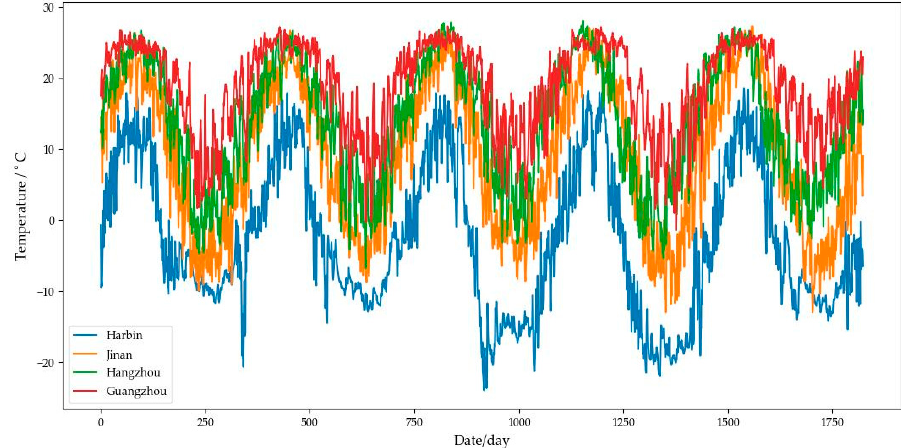
Figure 11. Temperature trend map of various regions.